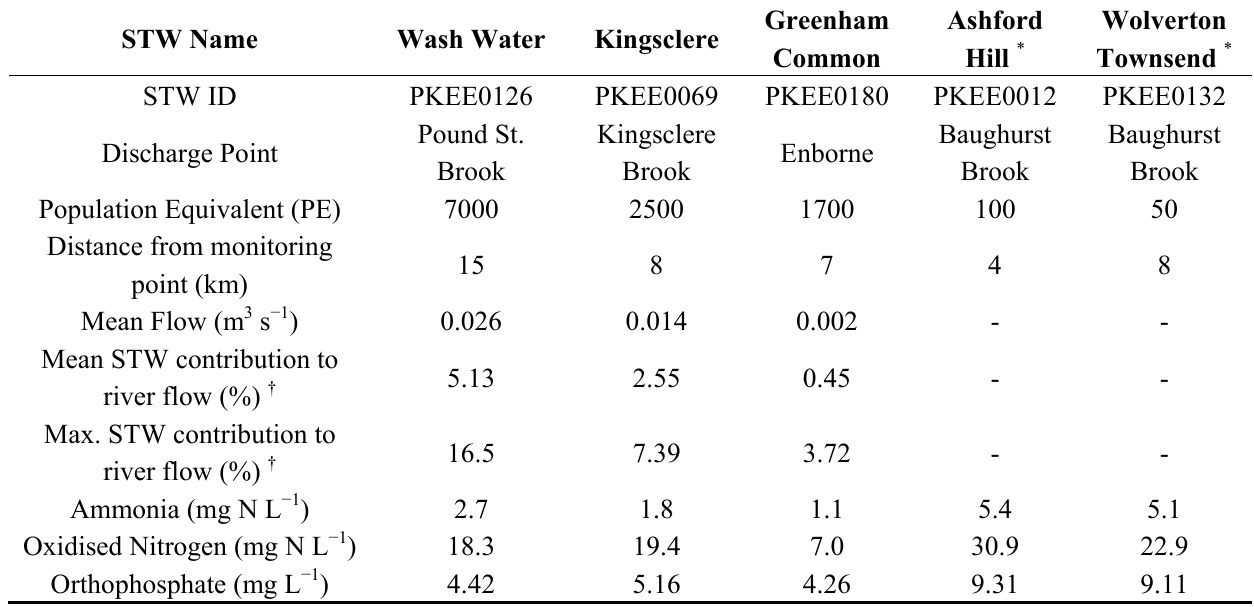
Table 3. Information on the major sewage treatment works (STW) discharges affecting the Enborne. Locations are shown in Figure 1. Mean flow and mean concentrations are presented based on weekly to monthly measurements made between November 2009 and February